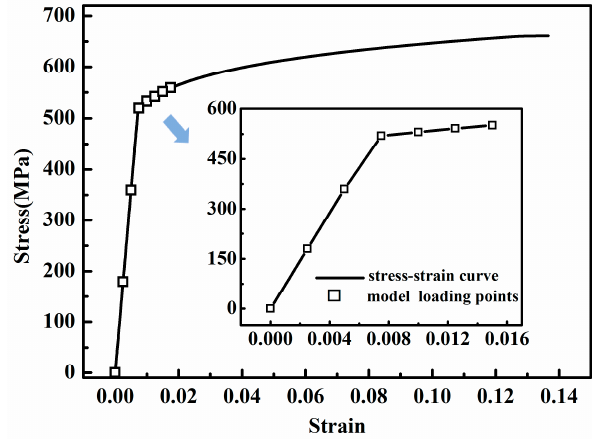
Figure 5. Stress–strain curve of Al 7075-T651 plate with maximum strains loaded for the seven models.